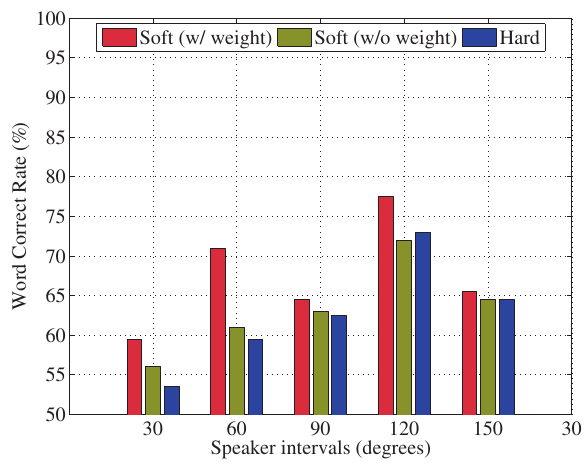
Figure 11. Word correct rate for the right speaker.